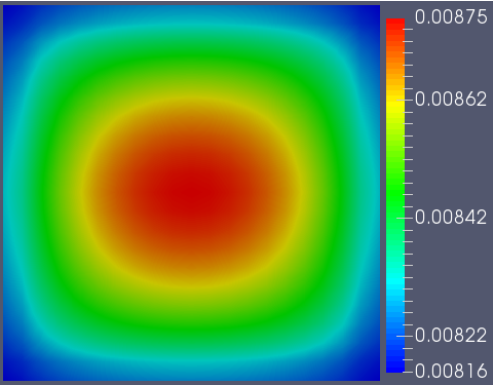
Figure 3. Coke distribution patterns at 32